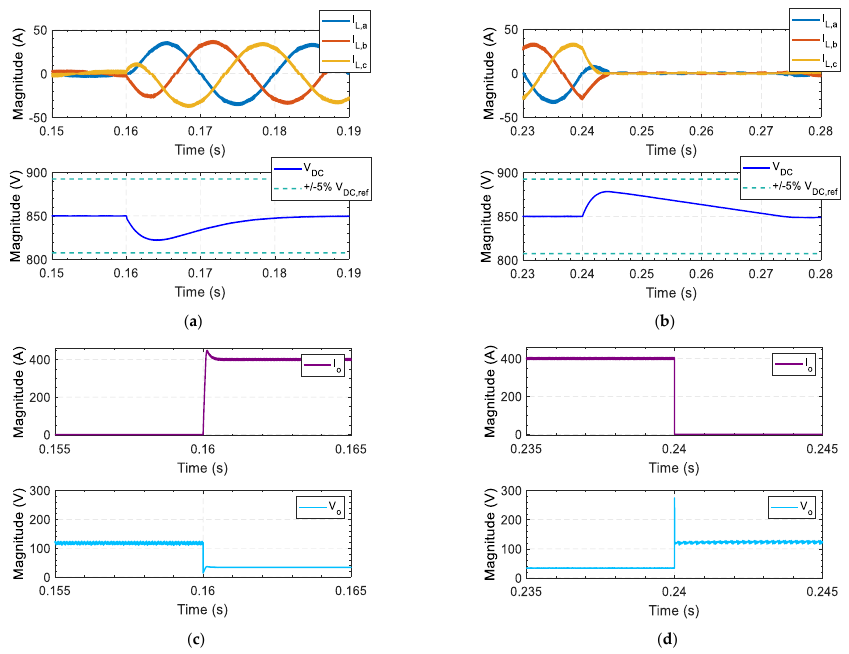
Figure 16. Grid current, DC voltage bus and output physical quantities waveforms during ( a , c ) transient from no-load to on load and during ( b , d ) transient from on load to no-load. In the absence of electric arc, thus with a null output current, the return of the volt- age bus to its reference value is slower after a voltage peak since the circuit dynamics for draining the energy stored in the DC bus capacitors is slower. As with short-circuits, the 878V (+3.29%) voltage peaks and 822 V ( − 3.29%) voltage dips are less than 5% of the DC bus reference value. The regulation can therefore be considered satisfactory.